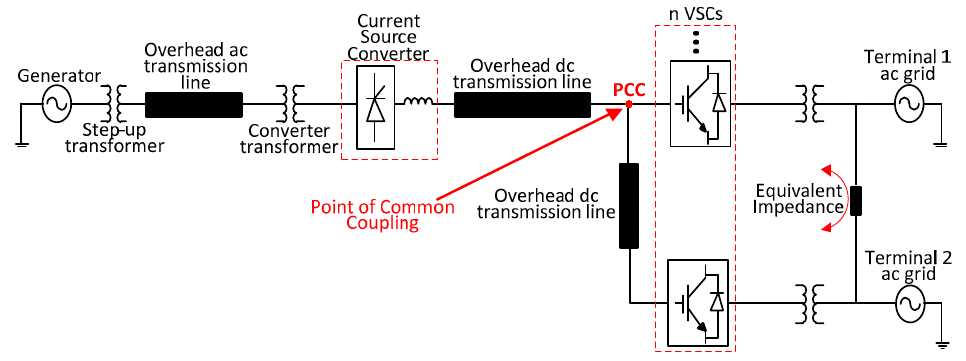
Figure 1. Proposed Hybrid HVDC System topology. PCC: point of common coupling.